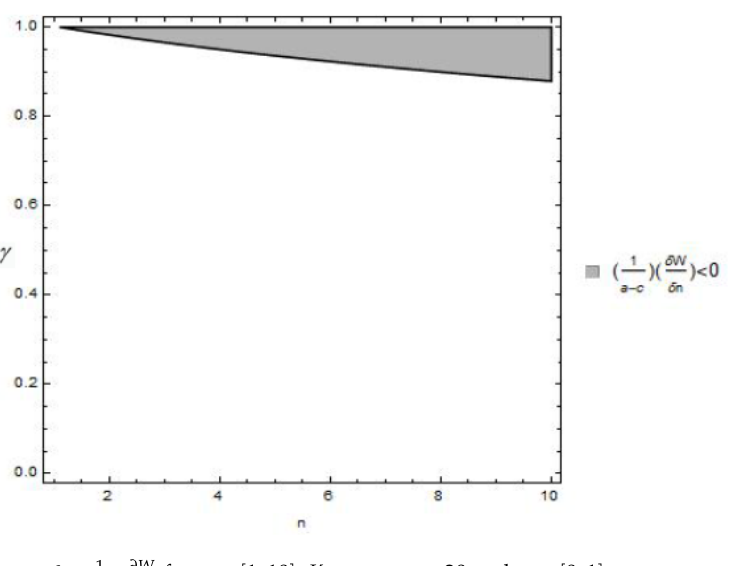
∂ W Figure 6. (cid:2869) ((cid:3028)(cid:2879)(cid:3030))(cid:3105)(cid:3024) for 𝑛 ∈ [1,10] , 𝐾 = 𝑚 + 𝑛 = 20 and 𝛾 ∈ [0,1] . Figure 6. 1 for n ∈ [ 1,10 ] , K = m + n = 20 and γ ∈ [ 0,1 ] . ( a − c ) (cid:3105)(cid:3041) ∂ n The shaded (white) region in Figure 6 shows 1 The shaded (white) region in Figure 6 shows